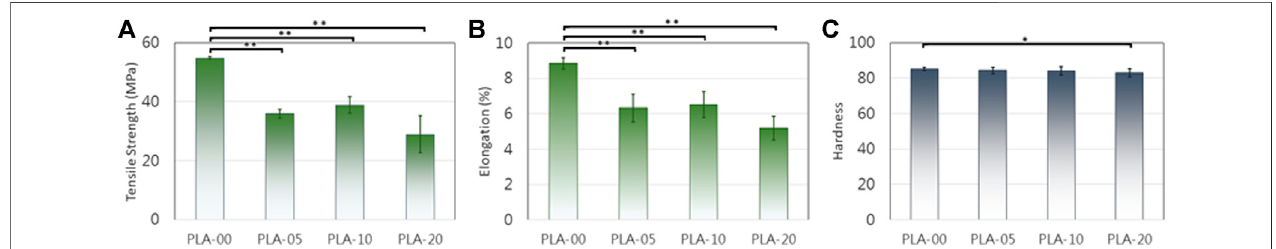
FIGURE 3 | PLA mechanical changes after β -TCP addition. (A) and (B) D638 tensile strength/modulus. (C) D412 hardness (* p < 0.05, ** p < 0.01).